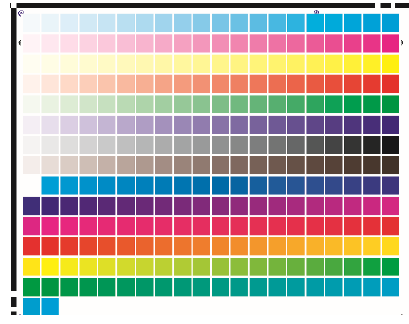
Figure 1. Printed Color scale for testing [22].